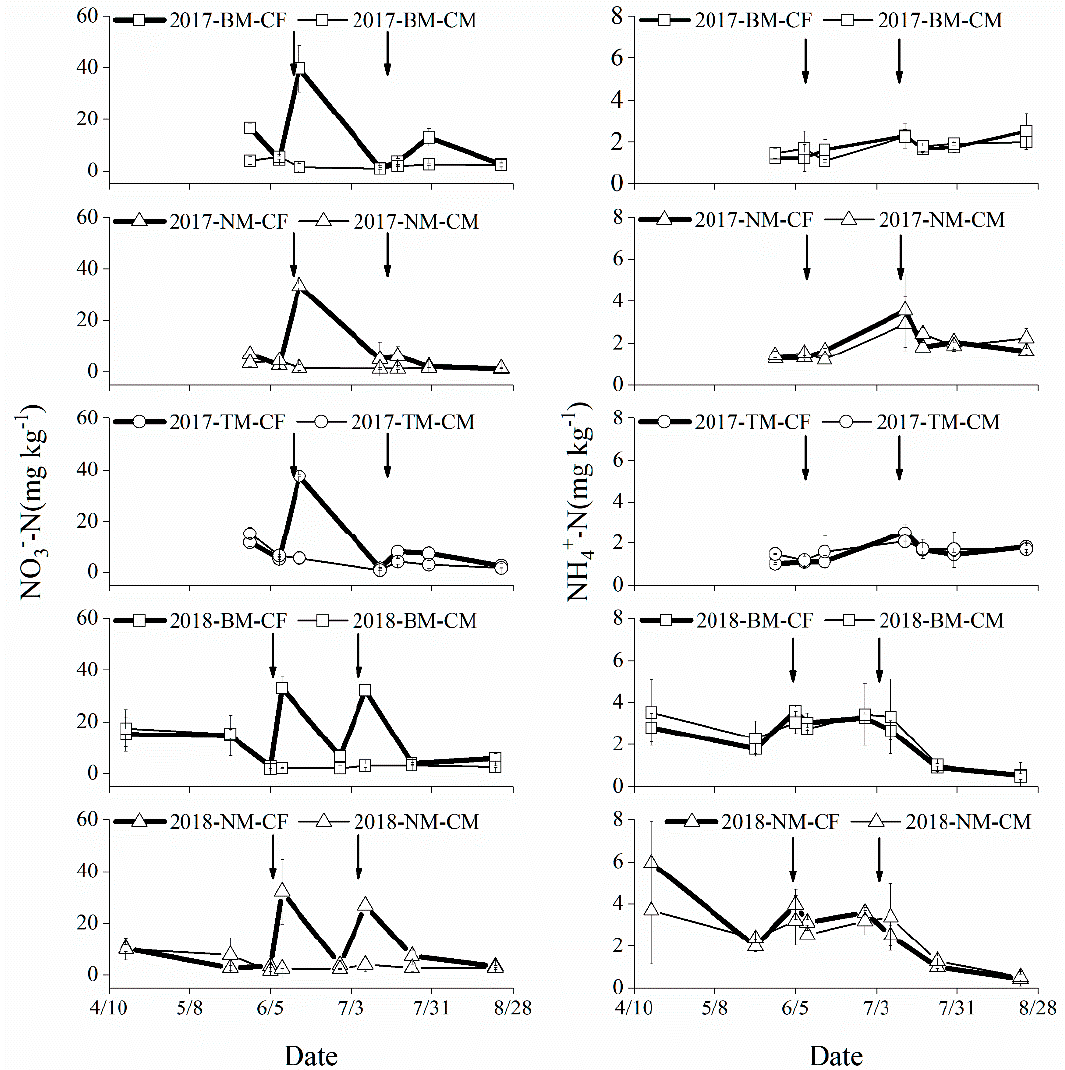
Figure 2. Soil nitrate nitrogen and ammonium nitrogen at 20 cm soil depth for the different kinds of fertilizer and different soil surface treatments for potato production at Wuwei, China: inorganic fertilizer (IF) and cattle manure (CM); black plastic-film mulch (BM), transparent plastic-film mulch (TM) and no mulch (NM) during 2017 and 2018. Arrows indicate dates of inorganic fertilizer topdressing: June 11 and July 15 in 2017 and June 6 and July 5 in 2018. Bars represent standard deviations ( n = 2). Values are means of two replicates.